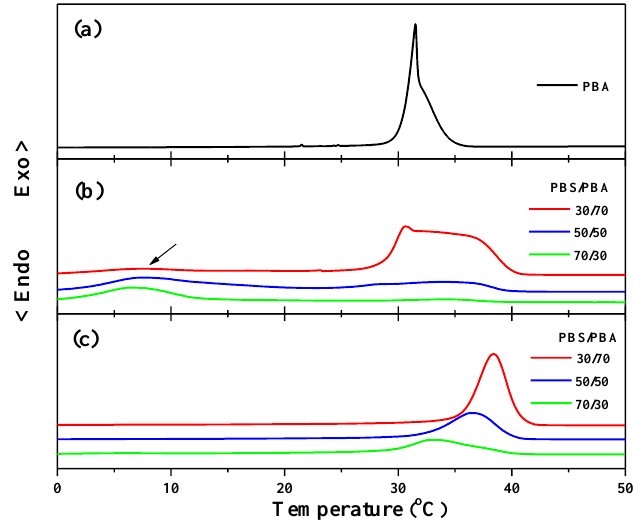
Figure 1. DSC cooling curves of ( a ) neat PBA, ( b ) PBS/PBA blends, and ( c ) sheared PBS/PBA blends from 80 °C at the cooling rate of 5 °C/min.